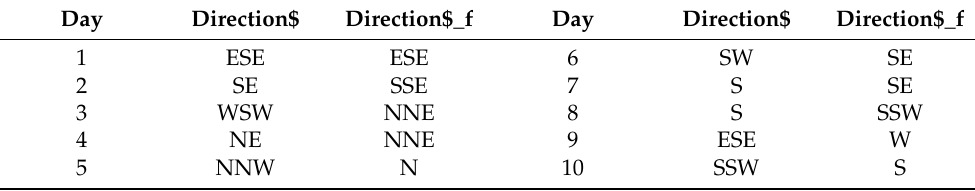
Table 3. Example data for measured values of wind direction and corresponding weather forecasts.